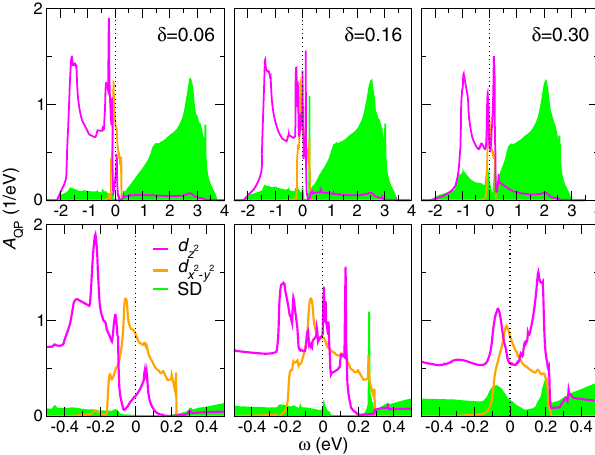
FIG. 12. Orbital-resolved k -integrated QP dispersion for selected hole dopings δ based on the minimal-Hamiltonian approach. Top (bottom): Wide (narrow) energy window. Since there are no Hubbard bands in mean-field RISB, note that each orbital spectrum is multiplied by the respective Z the proper relative QP weight.